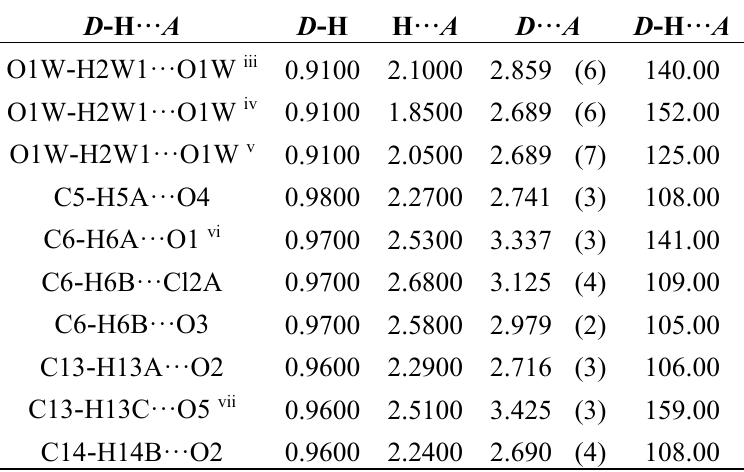
Table 5. Hydrogen-bond geometry (Å, °) of compound 2a